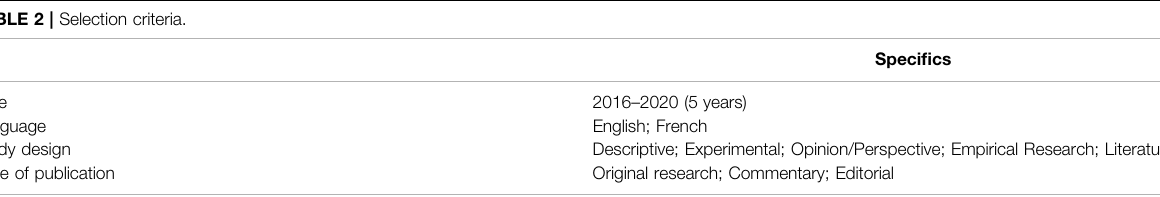
TABLE 2 | Selection criteria.